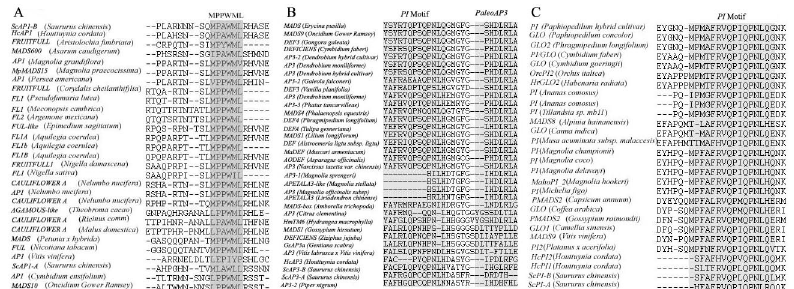
Fig 7. Comparison of the C-terminal region of amino acid sequences for MADS-box B class genes. ScAP1-A and ScAP1-B have a conserved MPPWML motif in the C-terminal region. ScAP3-A and ScAP3-B shared a PI-derived motif and a characteristic ancestral paleoAP3 motif. ScPI-A and ScPI-B protein has the highly conserved sequence PI- motif in the C-terminal region.